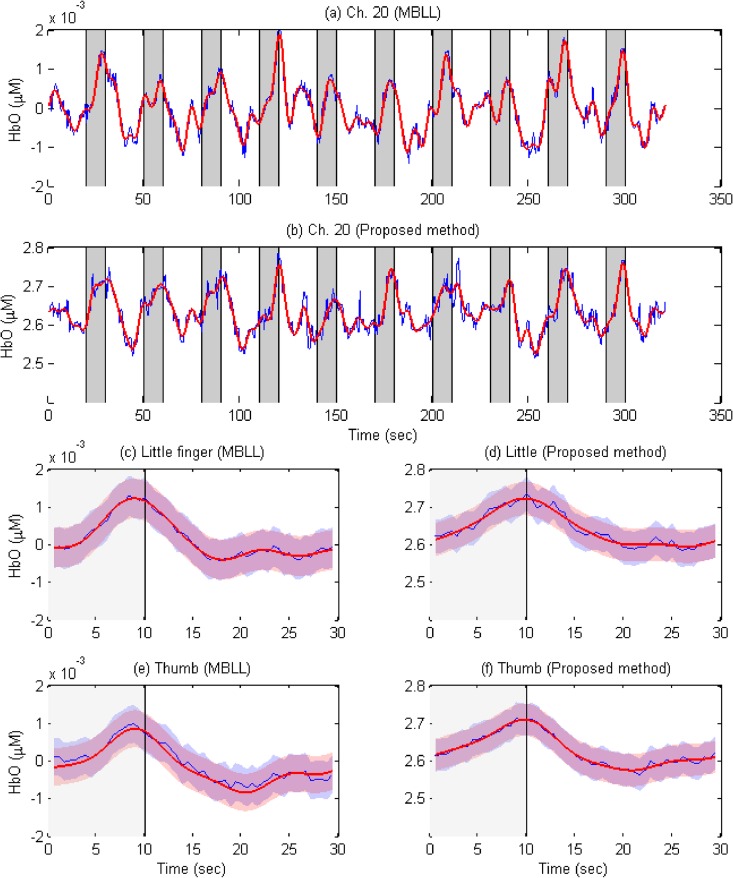
Comparison of the HbOs computed by the conventional MBLL method and the bundled-optode approach (Ch. 20, Subject 5, blue thin curves: raw data, red thick curves: low-passed filtered).(a) HbOs computed by the MBLL approach; (b) HbOs computed by the proposed method; (c)-(d) the averaged HbOs of the little finger movements (averaged over trials 1, 4, 6, 7, and 9) in (a)-(b), respectively; (e)-(f) the averaged HbOs of the thumb finger movements (averaged over trials 2, 3, 5, 8, and 10) in (a)-(b), respectively; the boundaries in (c)-(f) denote one standard deviation.